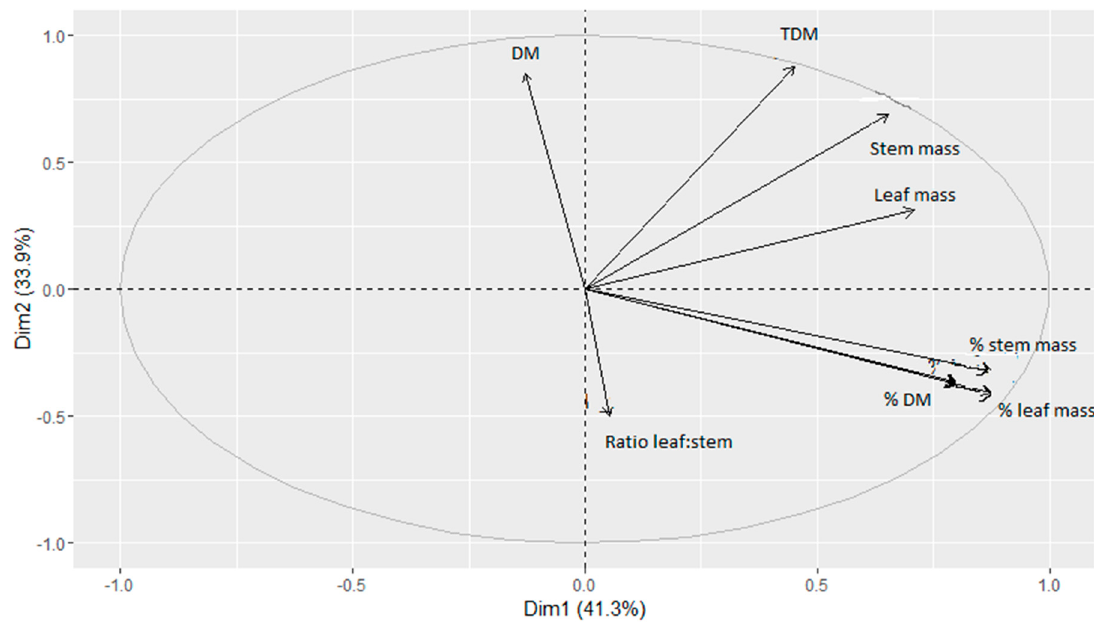
Figure 2. Principal component analysis between forage mass and the sward structure variables between 2008 and 2014. Dim 1 (principal component 1), Dim2 (principal component 2), TDM—herbage mass, DM—dead material, dead material % (% DM).